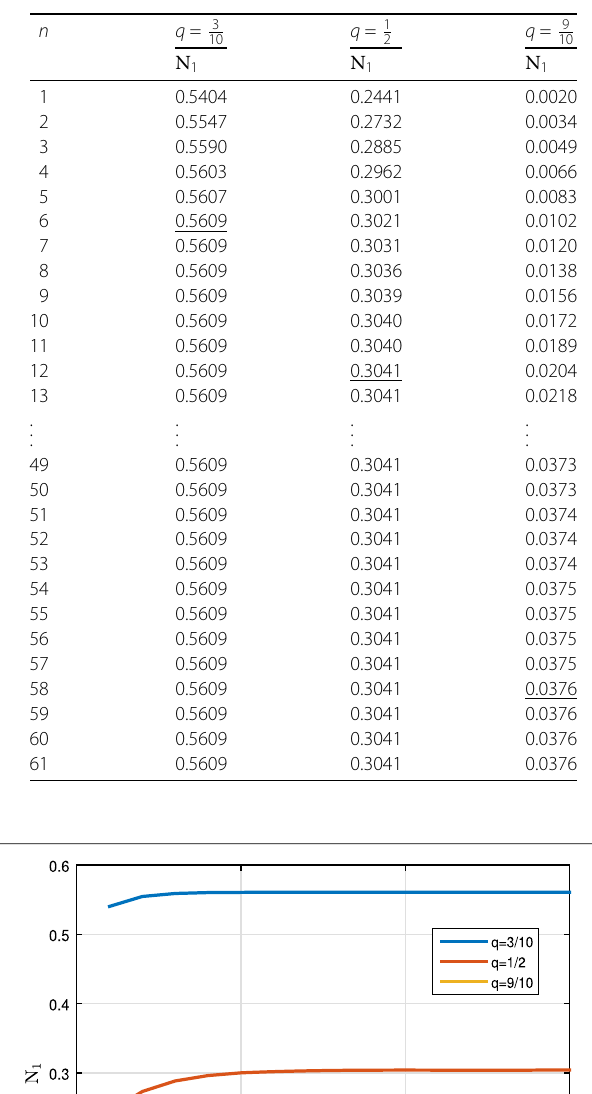
Table 3 Numerical results of N 1 of F D q – DP (21) with q ∈ { 3